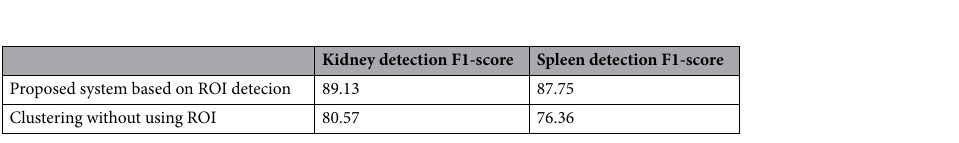
Table 3. Average F1 score for the cluster-based system before and after detection of the ROI. The results show the influence of the ROI on the final organ recognition.